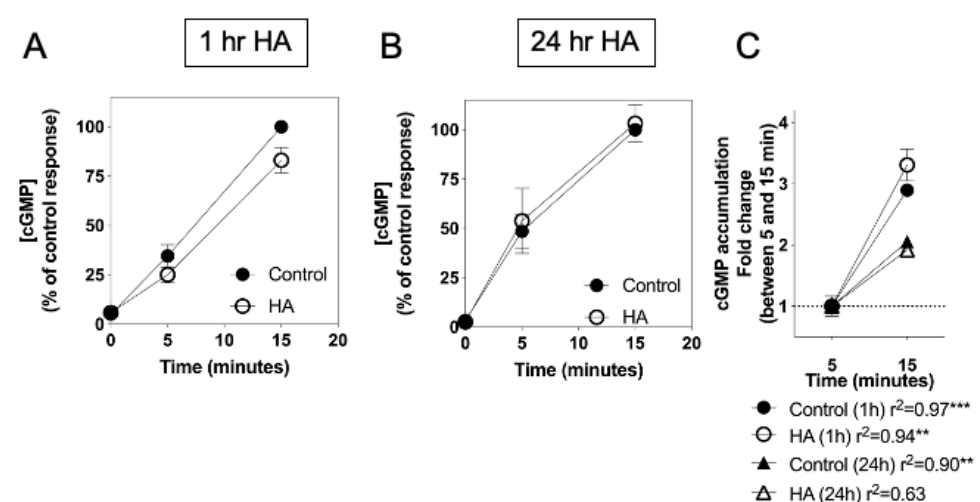
Figure 4. Effects of hyperammonaemia on SNP-stimulated cGMP accumulation in rat C6 glioma cells. Cells were initially treated in media containing 1% ( v / v ) FCS and 0 or 10 mM NH 4 Cl (HA) for either ( A ) 1 h or ( B ) 24 h, prior to subsequent stimulation with 1 mM SNP in the presence of 1 mM IBMX for up to 15 min. The data shown are means ± SEM of three independent experiments, each performed in triplicate and are expressed as the percentage of the control response to SNP. ( C ) Linear accumulation of cGMP between 5 and 15 min of SNP stimulation. Data shown are normalized to cGMP accumulation after 5 min, expressed as means ± SEM of three independent experiments. ***P<0.001, **P<0.01, significantly deviates from zero.